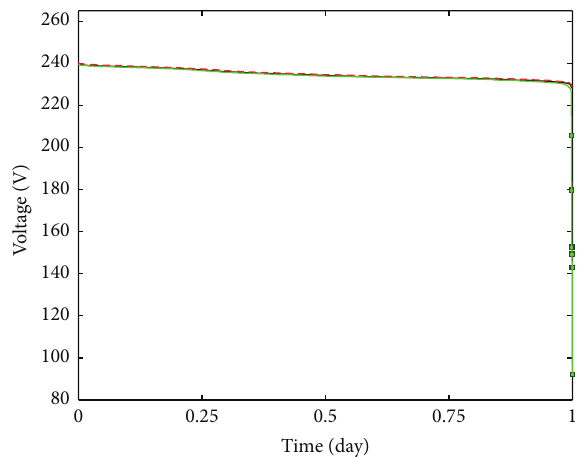
Figure 4: Voltages of the first facility during the recording period with the values sorted in descending order.